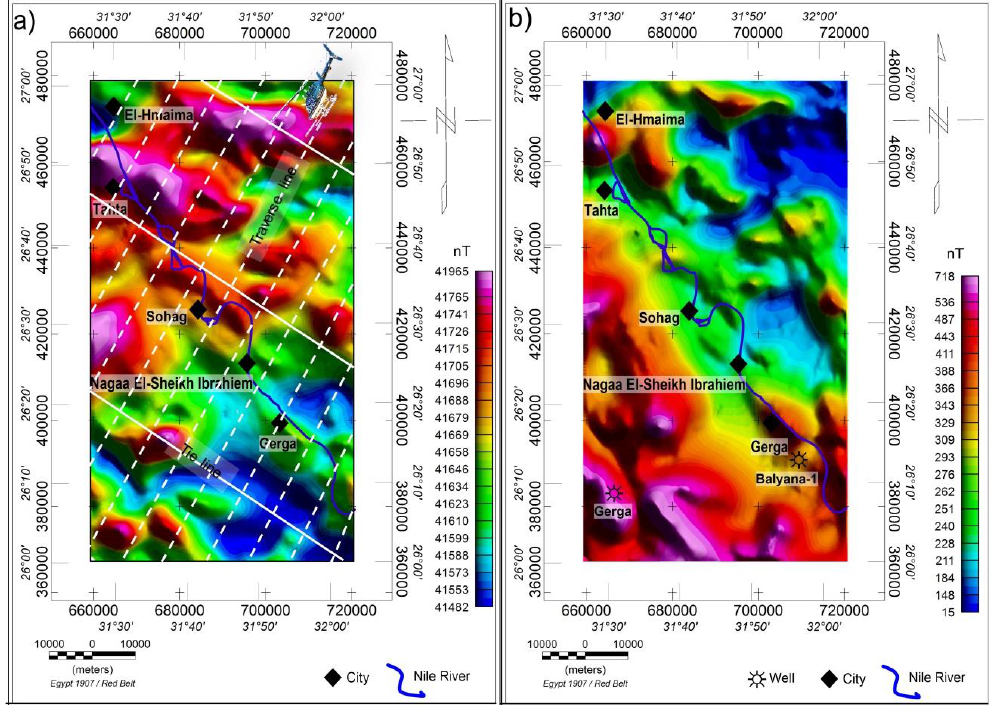
Figure 3. ( a ) Total magnetic intensity map of Sohag area and its surroundings. White dashed lines represent some flying transverse profiles (interval distance is 1.5 km), whereas white lines refer to some tie lines (interval distance is 5 km). ( b ) Reduction to the pole (RTP) magnetic map.